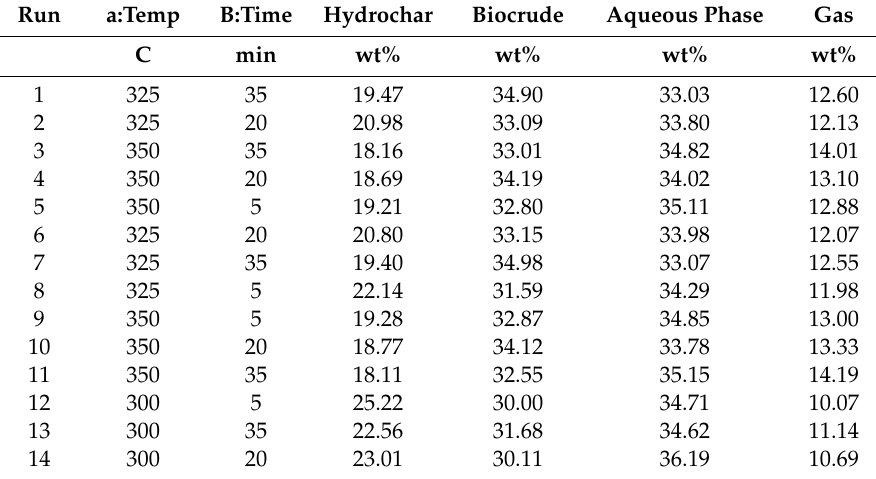
Table 2. Design of experiments by the I-optimal matrix of Design Expert